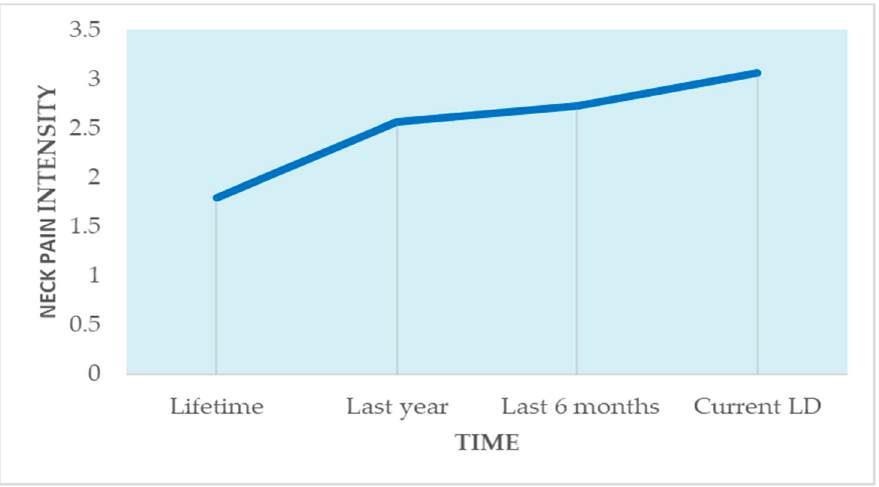
Figure 1. Neck pain at four time-points: lifetime, last year, last 6 months, and current, on a scale of